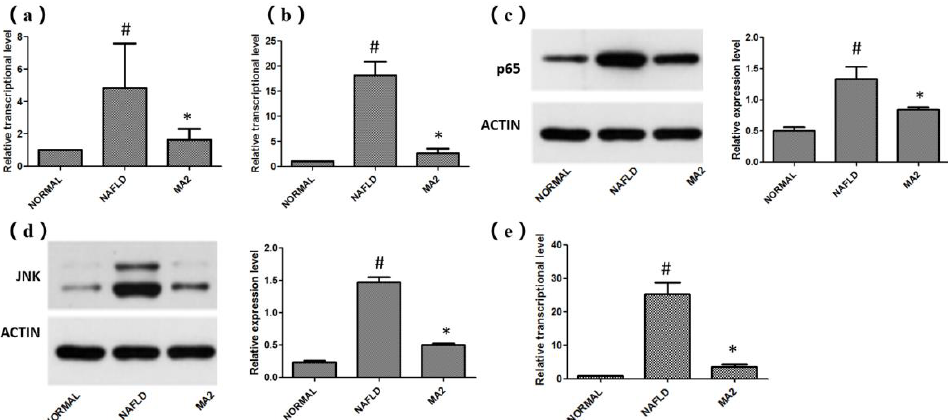
Figure 5. Effects of L. plantarum MA2 on the expression levels of related genes in rat liver LR4-MYD88 and its downstream pathways. ( a ) Relative transcription levels of TLR4 mRNA, ( b ) relative transcription levels of MyD88 mRNA, ( c ) the expression level of p65 protein, ( d ) JNK kinase activity, ( e ) relative transcription level of AP-1 mRNA. (# indicates p < 0.05 compared with the normal group; * indicates p < 0.05 compared with the NAFLD group. NORMAL: normal group, NAFLD: non-alcoholic fatty liver disease, MA2: L. plantarum MA2 treatment group).